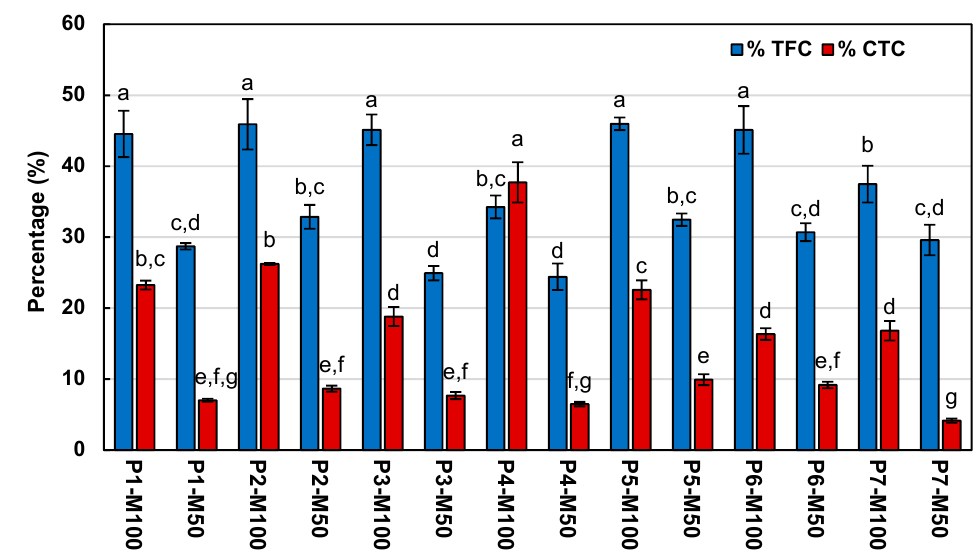
Figure 1. Average percentage of total flavonoid content (TFC) and condensed tannins content (CTC) from the total phenolic content (TPC) of methanolic extracts from Asclepias linaria leaves. Values are expressed as the mean ± standard deviation of three repetitions. Values with different letters indicate significant differences (Tukey, p < 0.05).